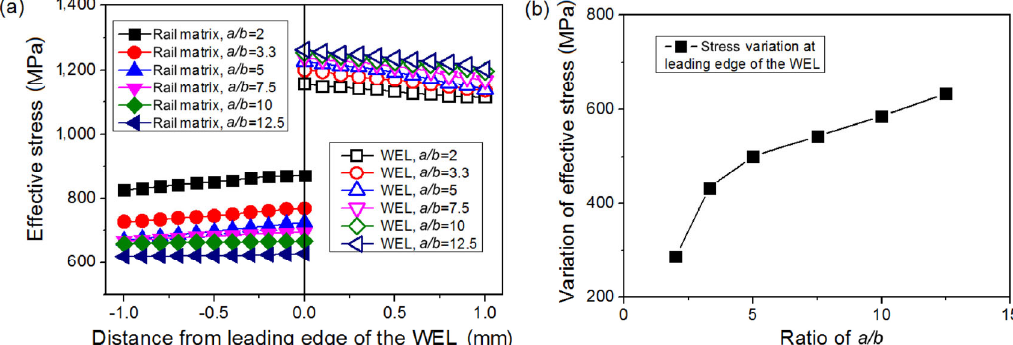
Fig. 9 (a) Distribution of effective stress around leading edge of the WEL for different WEL geometries, and (b) variation of effective stress between the WEL and rail matrix as a function of a / b .